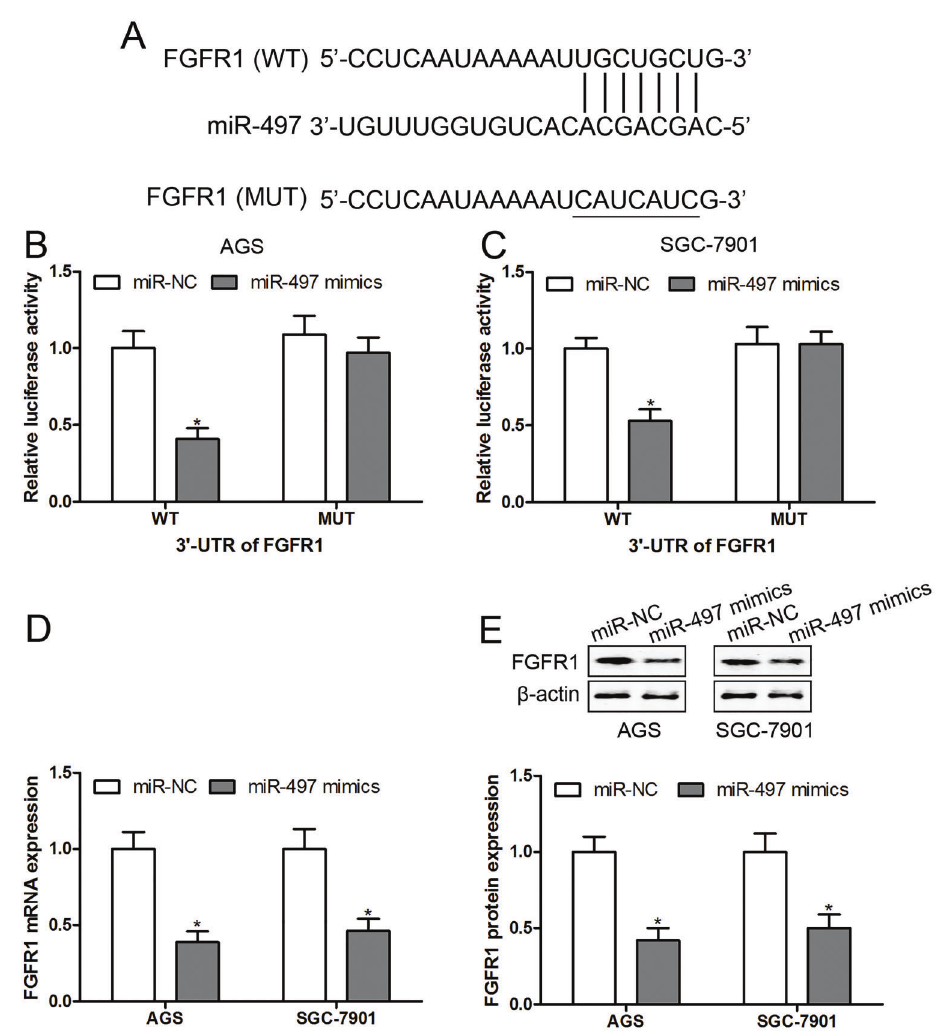
Figure 4. Putative miR-497 binding sites in the 3 0 -UTR of fi broblast growth factor receptor 1 (FGFR1) predicted by Targetscan and miRanda ( A ). AGS and SGC-7901 cells were co-transfected with the wild type (WT) or mutant (MUT) 3 0 -UTR of FGFR1 with miR-NC or miR-497 mimics, and the luciferase activity assay was performed after 48 h of transfection ( B and C ). The mRNA and protein expression of FGFR1 in AGS and SGC-7901 cells were measured by RT-qPCR and western blotting, respectively ( D and E ). Data are reported as means ± SE for n=3 in each group. *P o 0.05 ( t